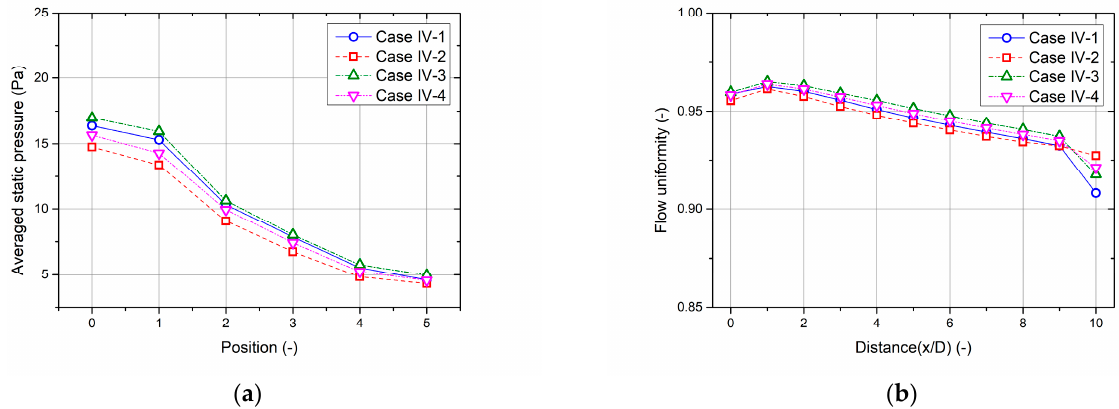
Figure 14. Simulation results: ( a ) static pressure distribution; ( b ) flow uniformity distribution.